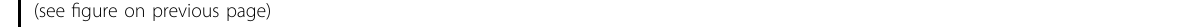
Fig. 6 More glial cells in the newborn monkey brain after LV injection of lentivirus targeting CHD8 at G55. a In utero delivery of lentiviral CHD8 gRNA/Cas9 into the LV of fetal monkey brain at ~G55. b Ultrasound image of injection of lentivirus into the LV of the fetal monkey brain at G55. Arrows indicate a needle. c Widespread expression of GFP, which re fl ects lentiviral CHD8 gRNA/Cas9 transduction in the brain of newborn monkey. Scale bar: 1 mm. d Neuronal expression of GFP in the newborn monkey brain cortex. Scale bar: 10 μ m. e GFAP labeling of the white matter of the brain cortical region in control and CHD8-targeted newborn monkeys. Scale bar: 1 mm. f Western blotting of the lentiviral-infected brain regions showing that CHD8 gRNA/Cas9 expression reduced CHD8 expression and increased levels of glial proteins (Sox9 and Olig2). g Double immunostaining of lentiviral-infected brain regions showing that CHD8 gRNA/Cas9 expression increased Sox9-labeled astrocytes and Olig2-labeled oligodendrocytes when compared with control gRNA/Cas9 expression. Scale bar: 20 μ m. h Quantitation of the relative number of oligodendrocytes and astrocytes. The data were obtained from one newborn monkey targeted by control gRNA/Cas9 and two newborn monkeys targeted by CHD8 gRNA/Cas9. Brain sections (1.3 mm apart from each other) from the brain cortical region in the control gRNA/Cas9 (six sections) and CHD8 gRNA/ Cas9 (eight sections) targeted monkeys were used for quantitative analysis. At least four images (×20) from each brain section were taken to obtain the average numbers of glial cells per mm 2 . The data are presented as means ± SEM ( n = 24 images for control gRNA/Cas9 and n = 32 images for CHD8 gRNA/Cas9). *** P <